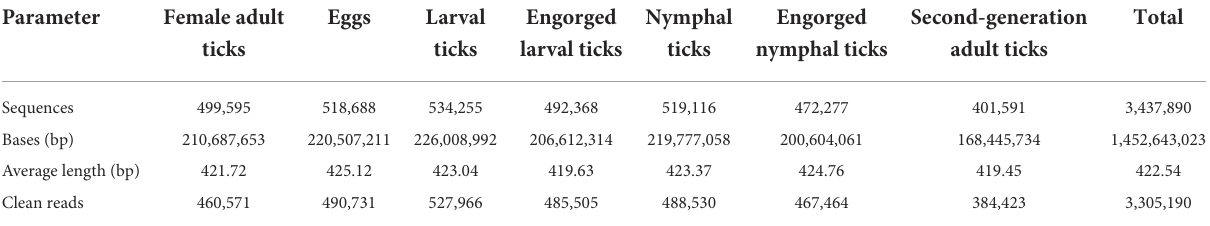
TABLE 2 Statistics of sequencing result.